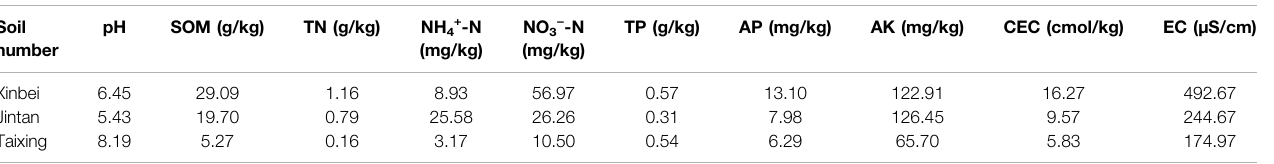
TABLE 3 | Physical and chemical characteristics of three soils. Soil